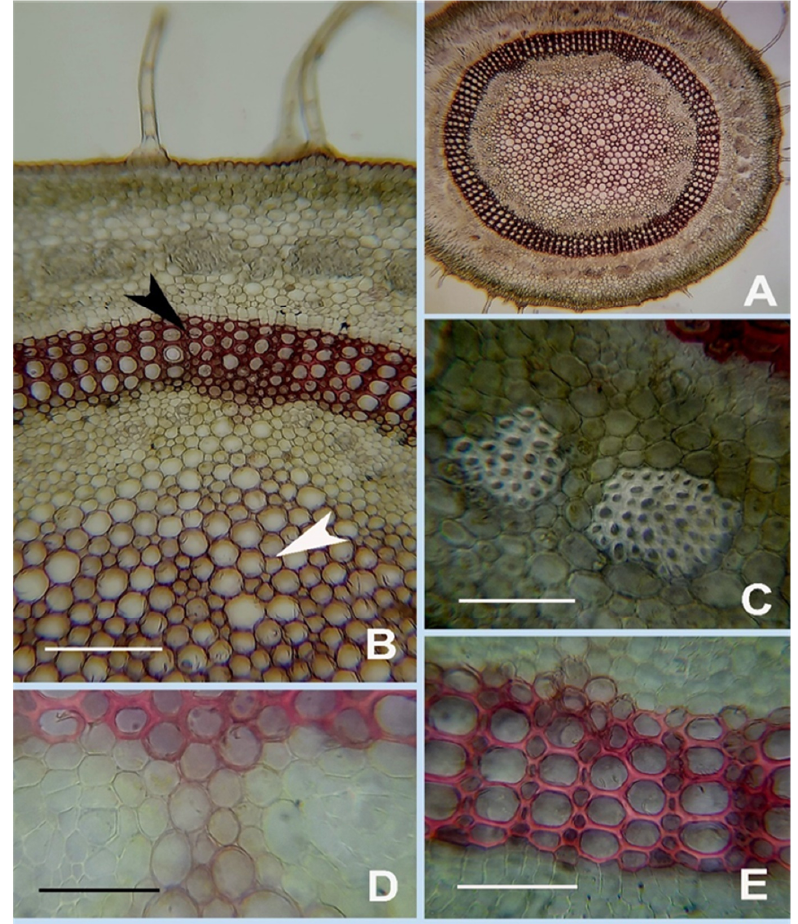
Figure 3. A. Lignification of cells in stem of second internode. B. Lignified metaxylem tracheids with ray cells (Black arrow) and lignified pith (White arrow), C. Cortical gelatinous fibres getting lignified. D. Inner phloem developing, E. Close up of Metaxylem. Scale bar: 400 µ (B), and 100µ (C, D, E) Secondary thickening from third internode